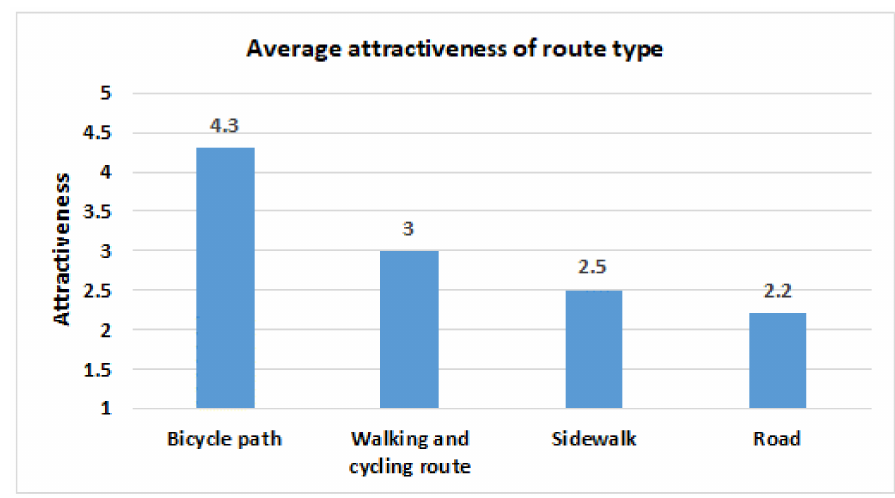
Figure 4. Attractiveness of the bicycle route to the user in terms of the route section type.